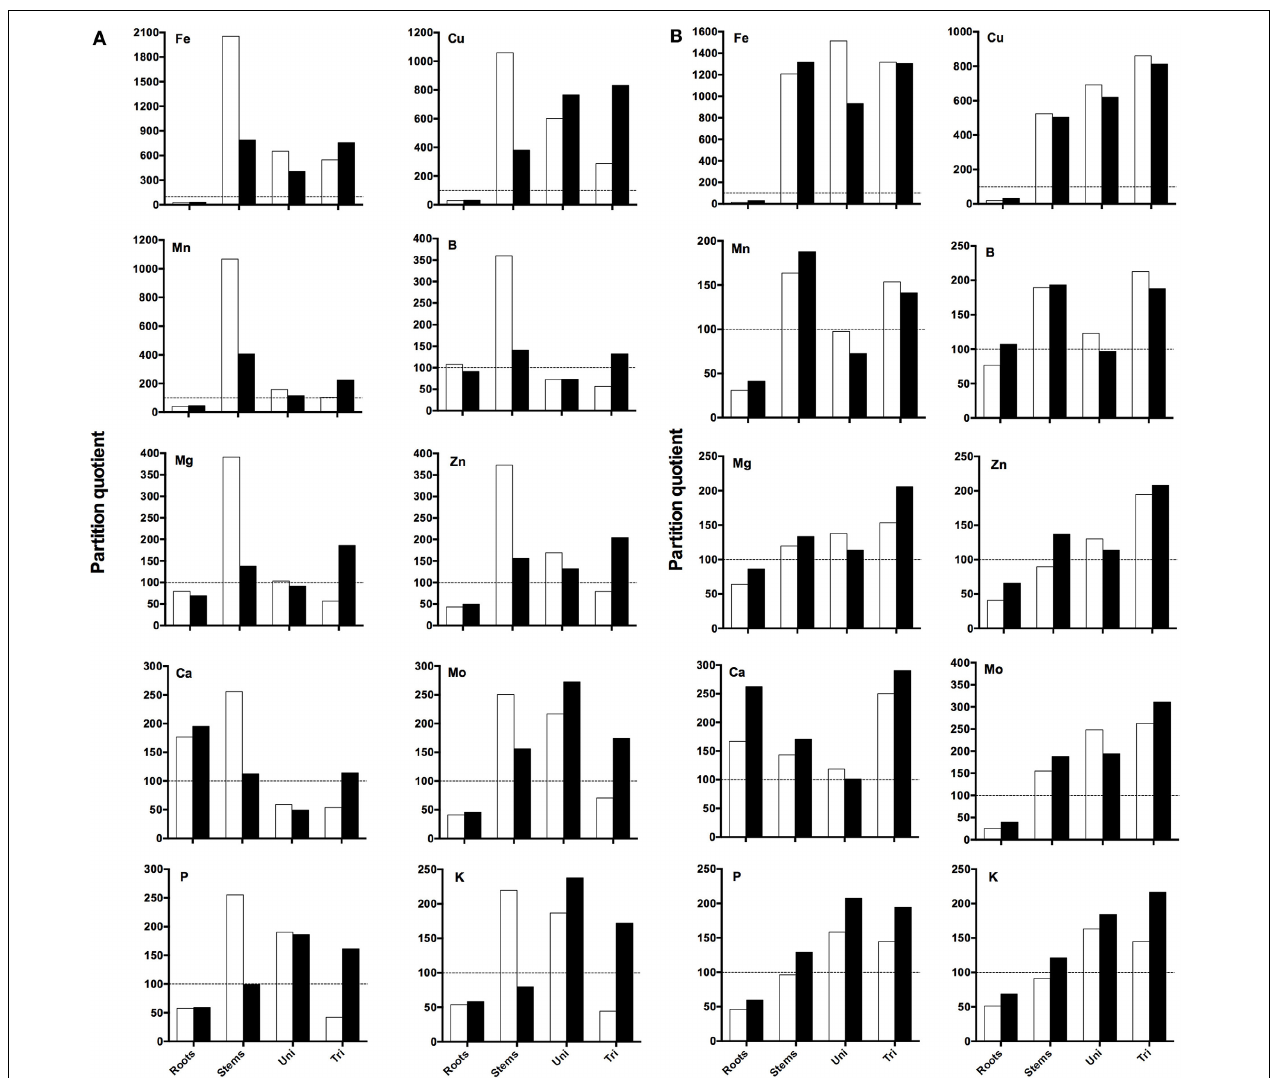
FIGURE 5 | (A) Partition quotients (PQ) of Fe, Cu, Mn, B, Mg, Zn, Ca, Mo, P, and K in roots, stems, cotyledons (Cot), unifoliate (Uni), and trifoliate (Tri) leaves of “Fe-efficient” (EF) accession grown under Fe-deficient (DEF) conditions at 60% (open bars) and 90% (closed bars) relative humidity (RH). Y-axis range varies among elements. Dashed horizontal line represents PQ of 100 (the percentage contribution of the organ to the plant dry weight (DW) is the same as the percentage contribution to the plant’s total content of the mineral being evaluated).